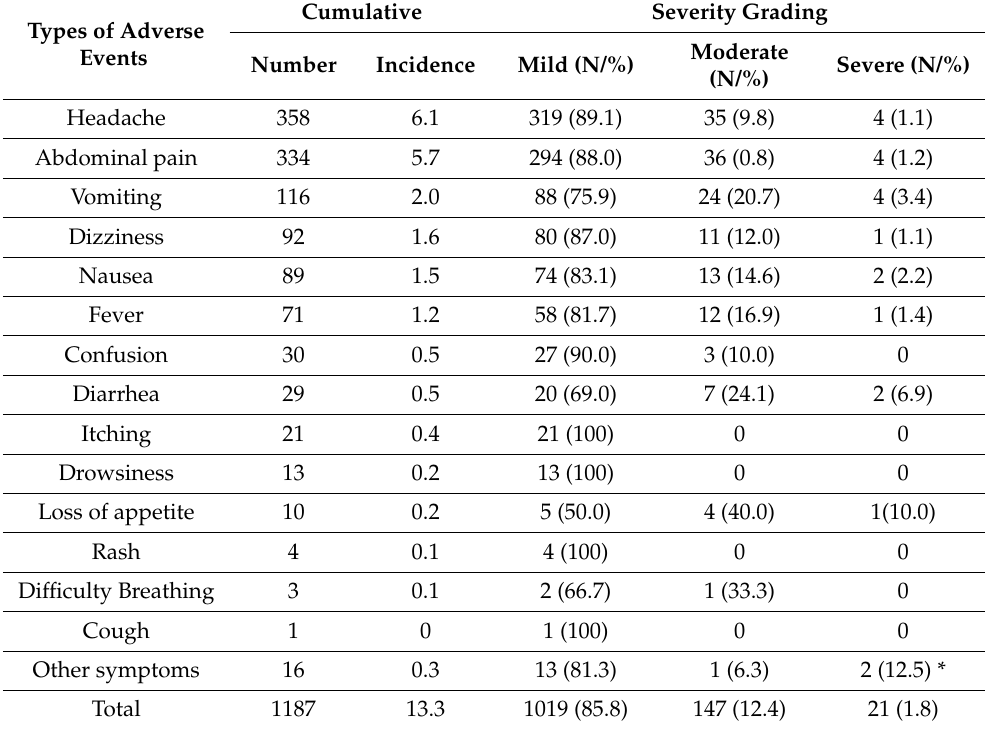
Table 2. Severity grading of AEs after mass praziquantel and albendazole